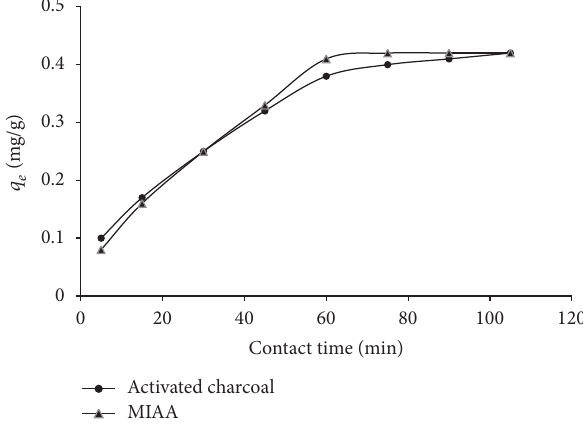
F 5: Effect of initial concentration of �uoride on adsorption capacity of (a) MIAA and (b) activated charcoal at 20